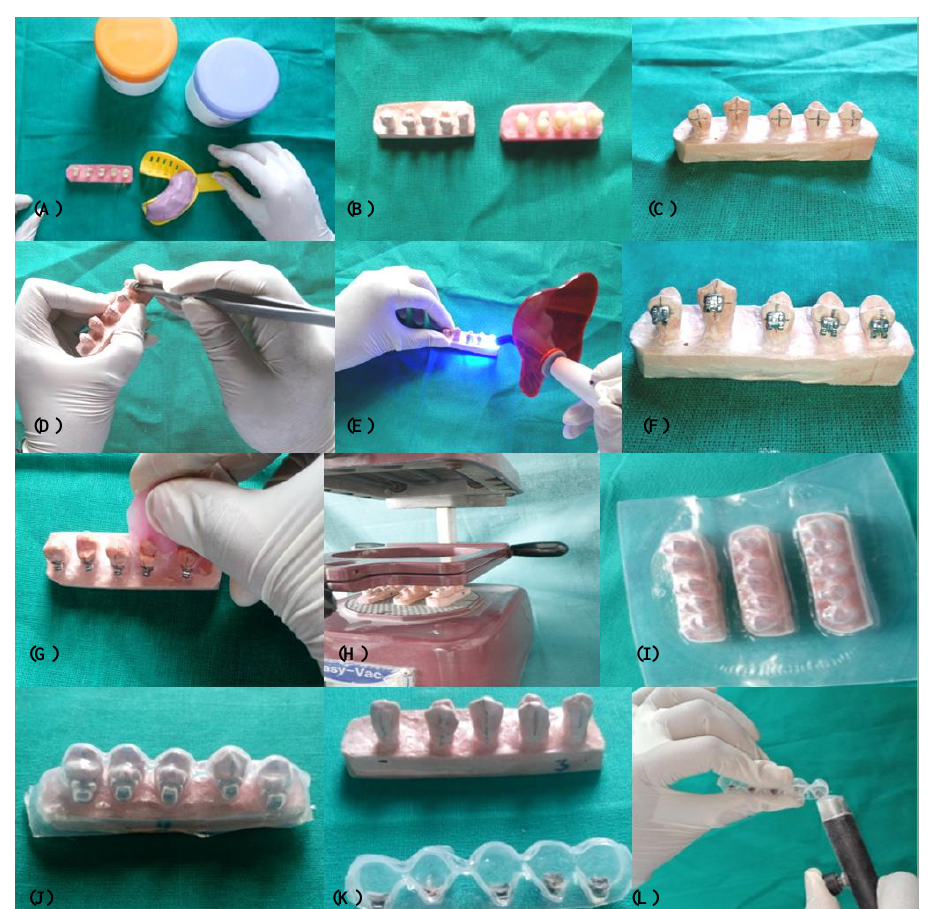
Fig. 2. Procedure for fabrication of transfer tray for Indirect bonding on labial surface. (A)Taking an impression of mounted teeth with polysiloxane impression material. (B) A model with mounted teeth and a working model. (C) Marking on a model for bracket placement. (D) Brackets placement on model and removal of excess material. (E) Curing of adhesive. (F) A working model with brackets. (G) Application of separating media. (H) Placement of working models in the lower compartment on easy vacuum press machine. (I) Adapted sheet on mounted model. (J) Trimming of the transfer tray of each working model. (K) A working model and its tray. (L) Sandblasting of bracket bases. For Group III, the Stb 7th generation lingual brackets of surface area lingual surface after sandblasting the bracket bases(Figs. 4 and 5). After that, 10.50 mm2 were firstly bonded on the plaster model using a DT3C Device all the groups were subjected to Universal Instron Testing Machine to caliper (Fig. 3). Then, a vacuum press sheet transfer tray; was bonded on the measure the Shear bond strength.